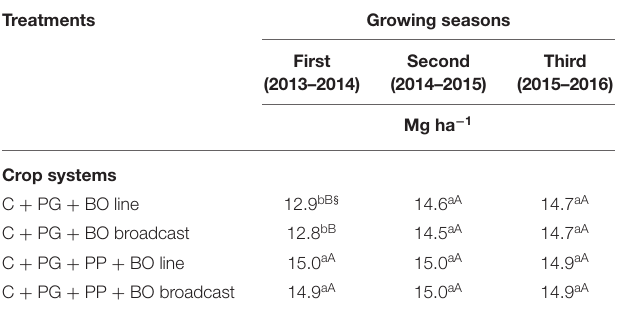
TABLE 5 | Forage mass of corn to silage intercropped with palisade grass (C + PG) and with palisade grass and pigeon pea (C + PG + PP) with black oat (BO) oversown in lines and broadcast in three growing